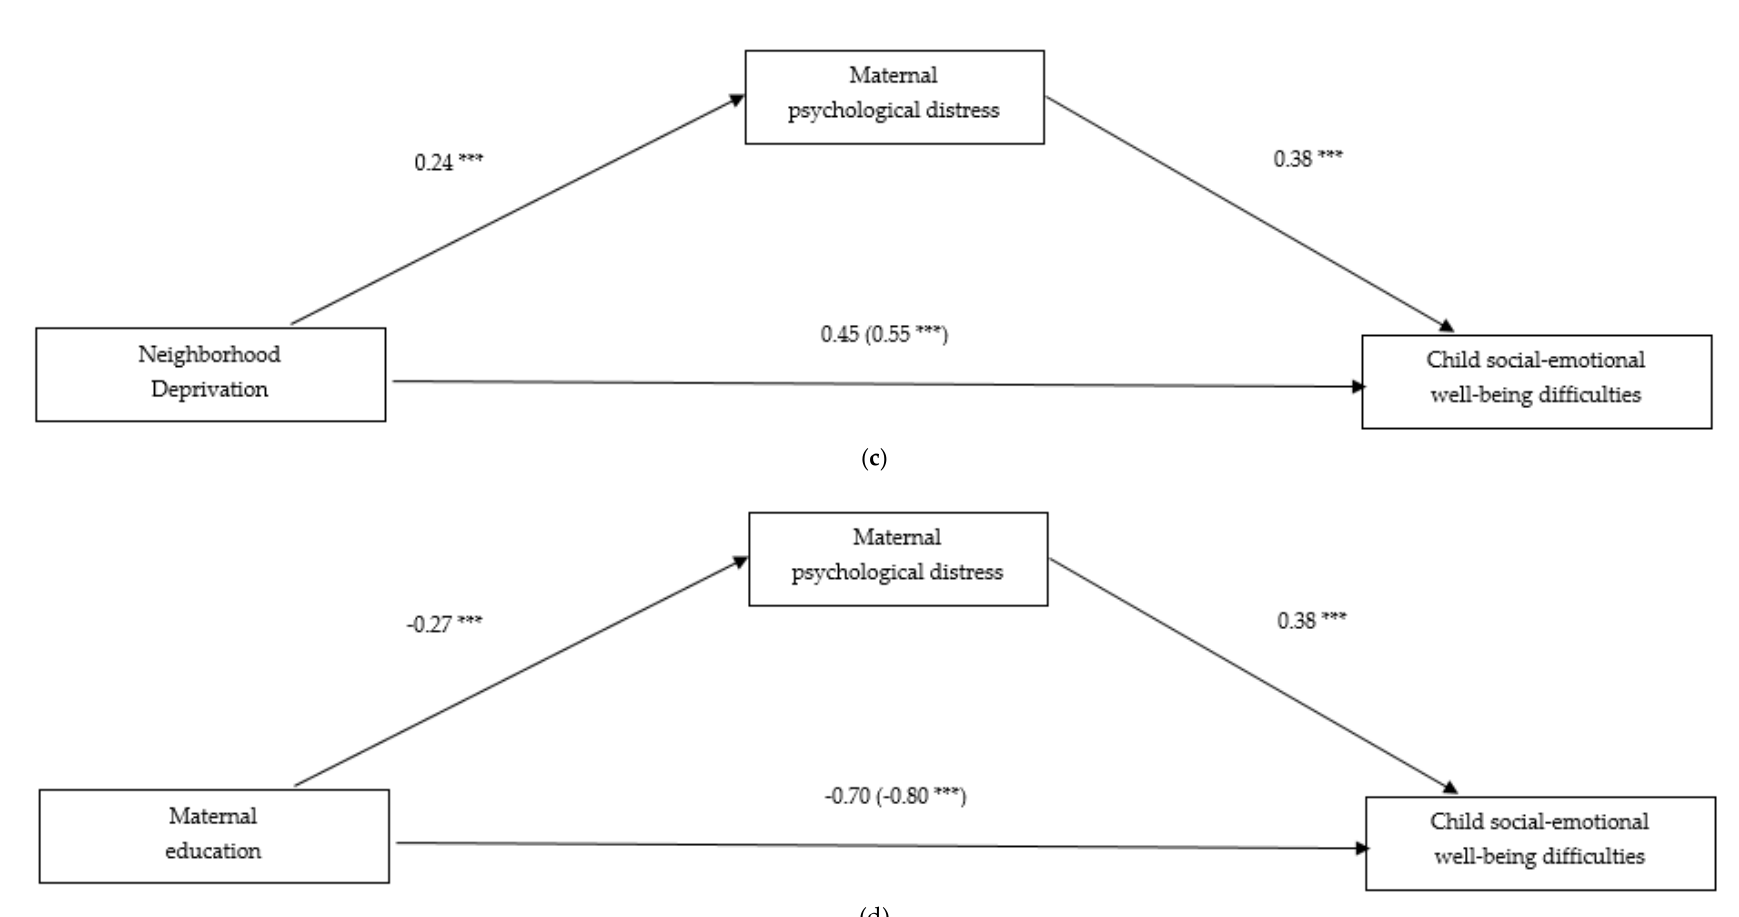
Figure 1. ( a,b ) Regression models predicting social-emotional well-being difficulties for boys. Values signify unstandardized regression coefficients. The direct effect of neighborhood deprivation and maternal education on social-emotional well-being are outside parentheses. The total effect is inside parentheses. *** p ≤0.001; ( c,d ) Regression models predicting social-emotional well-being difficulties for girls. Values signify unstandardized regression coefficients. The direct effect of neighborhood deprivation and maternal education on social-emotional well-being are outside parentheses. The total effect is inside parentheses. *** p ≤0.001.